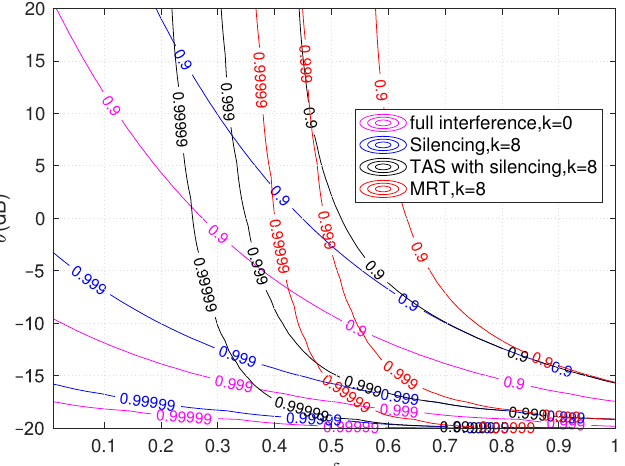
Figure 6. Illustration of reliability analysis for full interference, silencing, TAS with silencing and MRT schemes with respect to ratio of distances δ and threshold θ with N = 10 and k = 8 cooperating